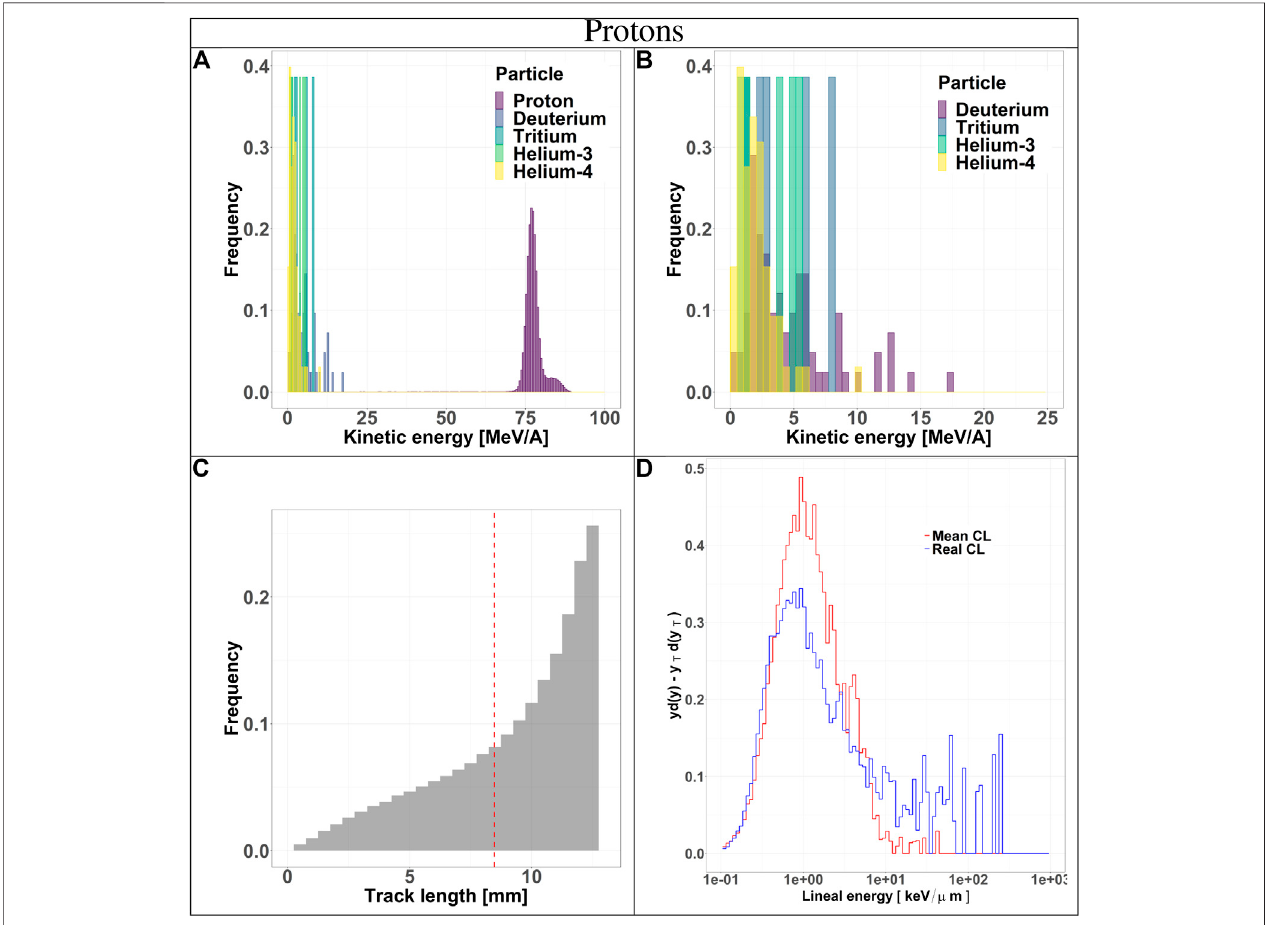
FIGURE9| Characterization oftheparticles lostbyHDMwhenirradiated with150 MeVprotonsatadepthof10.74 cminwater.Panels (A) and (B) :kineticenergy spectra of the most abundant components of the radiation fi eld including and excluding the primary ions. Panel (C) : track length distribution of all the particles detected by the TEPC. The mean chord length at 8.47 mm is marked with a red dotted line. Panel (D) : microdosimetric yd(y) spectra obtained with the mean chord length approximation (red line) and microdosimetric Y T d(y T ) spectra obtained using the real chord length values (blue line).